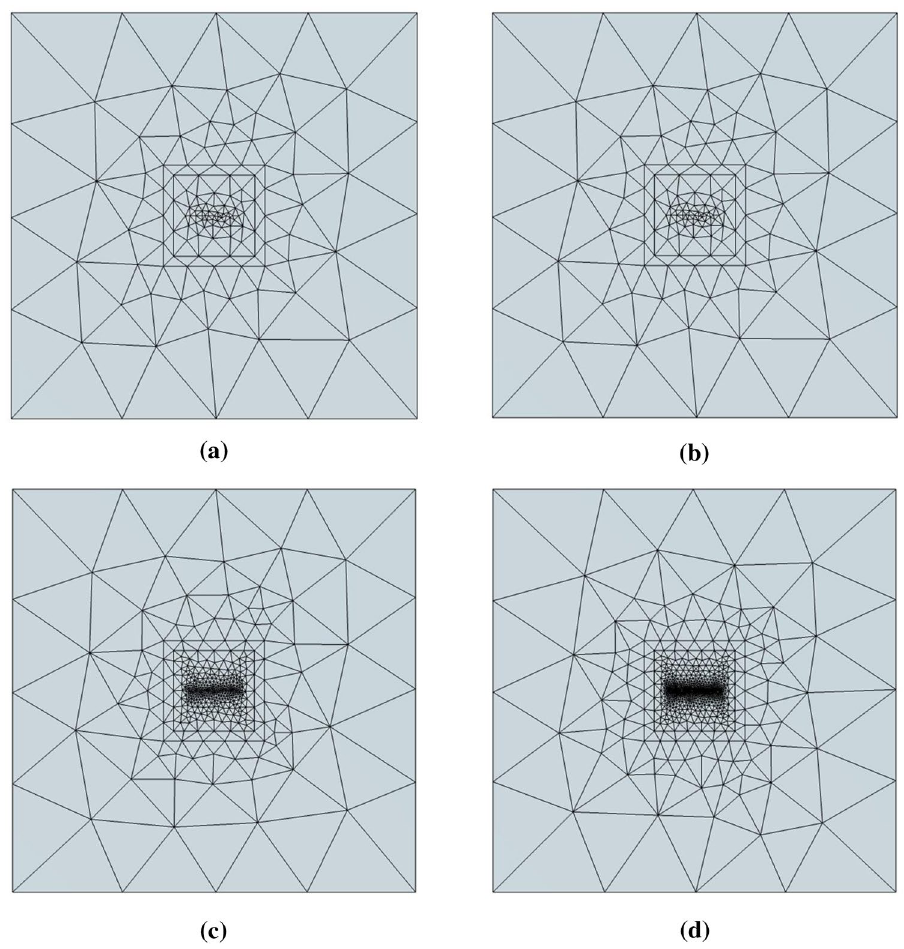
Figure 6. Mesh refinement at measuring points of the three-dimensional layered geoelectric model. ( a ) is the mesh refinement at the measuring points of Mesh A. ( b ) is the mesh refinement at the measuring points of